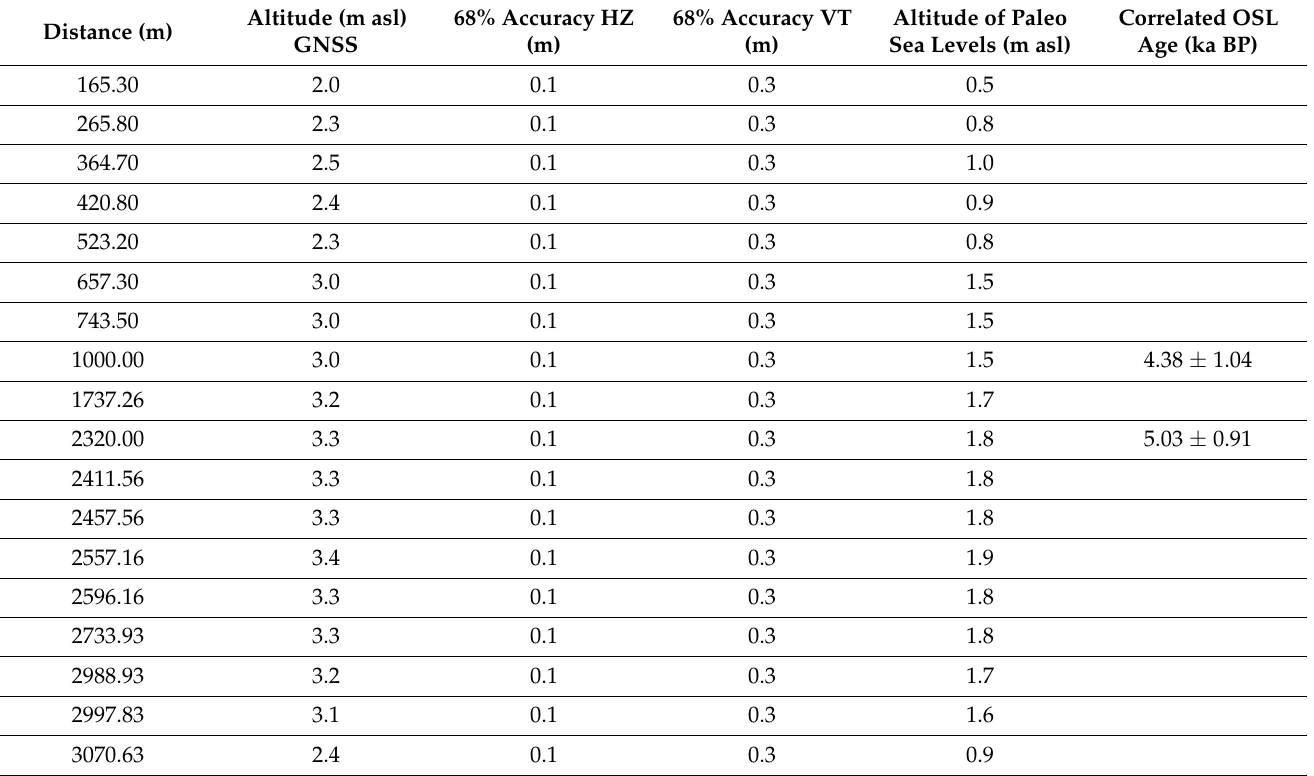
Table 2. Table showing the distances of the 24 points identified, with their respective mean and corrected altitudes, associated with the correlated OSL